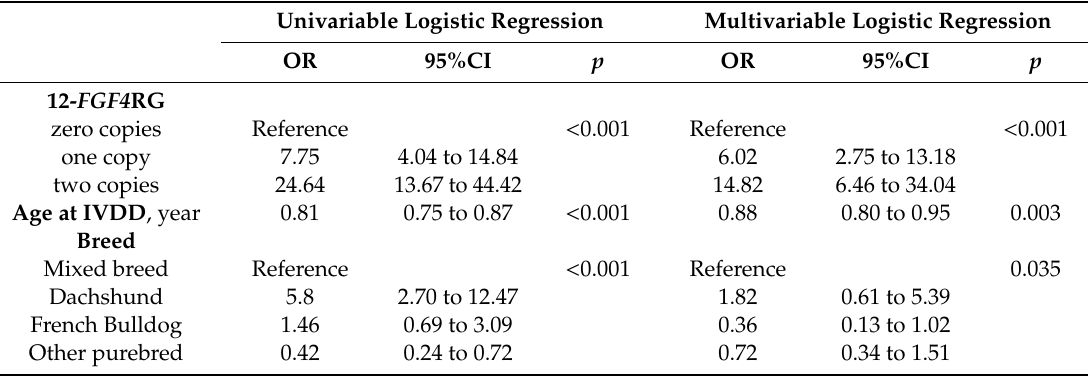
Table 4. Logistic regression analysis of factors associated with radiographically calcified discs. Results of univariable and multivariable logistic regression analysis of factors associated with having at least one radiographically calcified disc at the time of IVDD surgery in 423 dogs. Odds Ratio (OR). Univariable Logistic